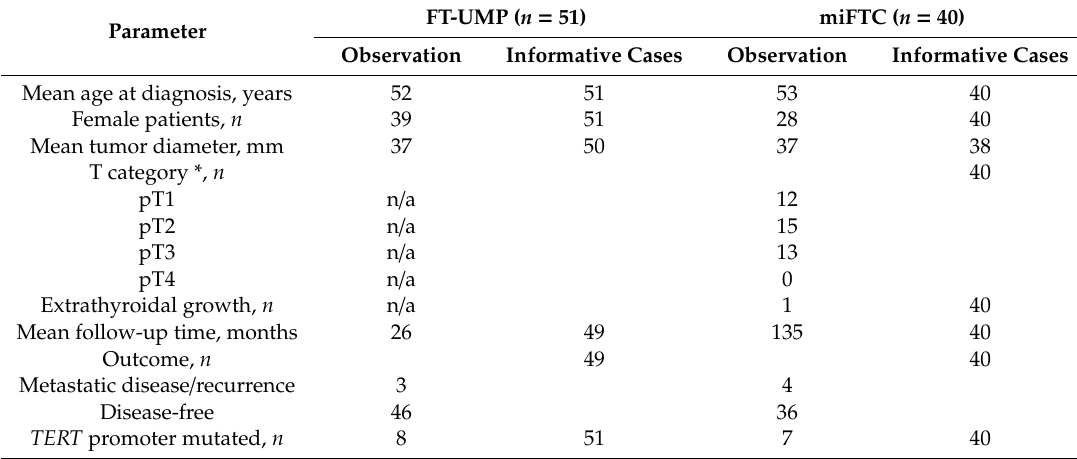
Table 1. Clinical characteristics of included tumor cases.